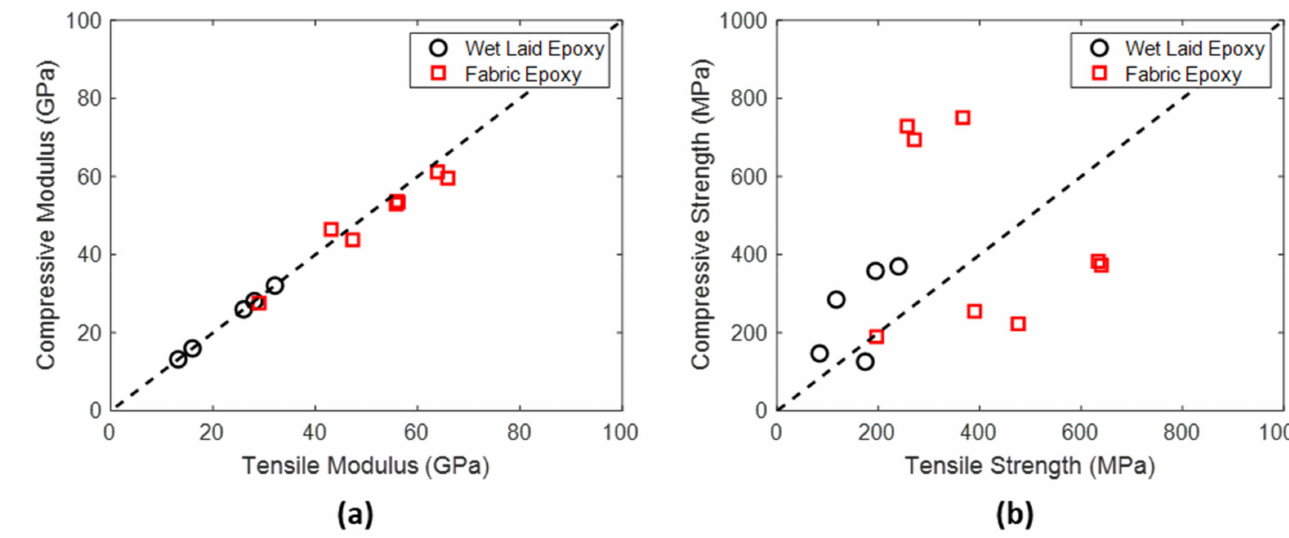
Figure 12. Comparison of tensile and compressive modulus ( a ) and strength ( b ) of recycled carbon fiber composites from literature [59,68–70,73,74]. Dashed line represents one-to-one correlation.